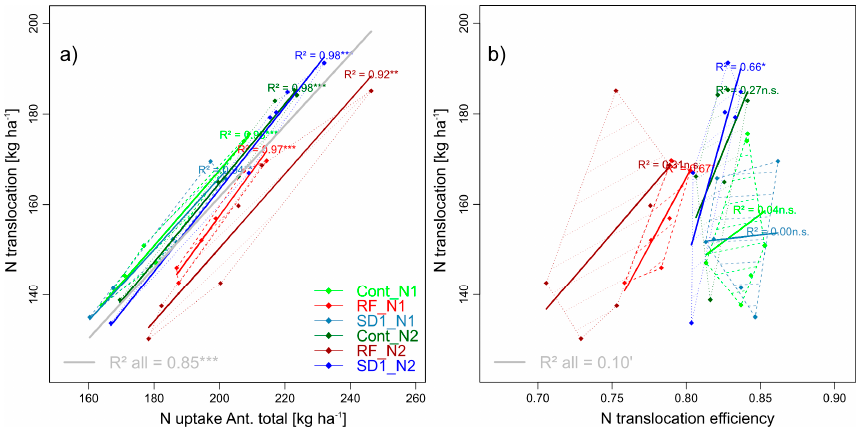
Figure 10. N translocation (NT) and its relation to total Nup at anthesis (left, kg N ha -1 , ( a )) and the apparent N translocation efficiency (NTEff, ( b )). N levels are distinguished by line types and color intensities (N1: Dashed lines and light colors, N2: Dotted lines and dark colors). Dashed and dotted lines delimit the bivariate data range covered by cultivars within MP × N-combinations. Colored regression lines indicate the linear trait relationships within MP × N-combinations and gray lines the regression line for the whole trial, calculated across the included data of reduced fungicide (RF), control (Cont) and sowing date 1 (SD1). Gray lines are only drawn for significant relationships ( p < 0.05). P -values of regression slopes are indicated as p < 0.01 (***), p < 0.01(**), p < 0.05 (*) and p < 0.1 (´).